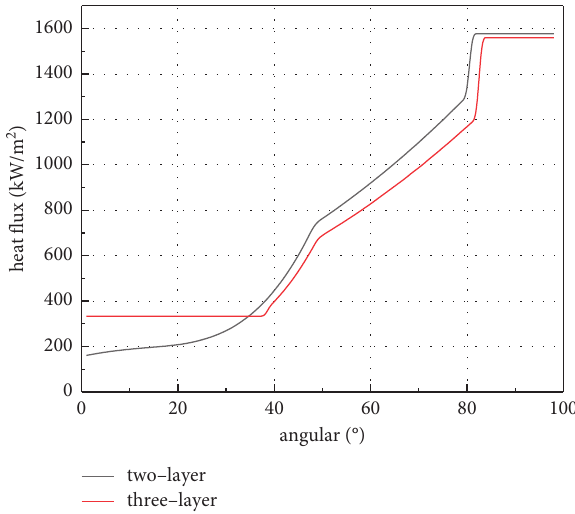
Figure 5: Heat flux distributions calculated by